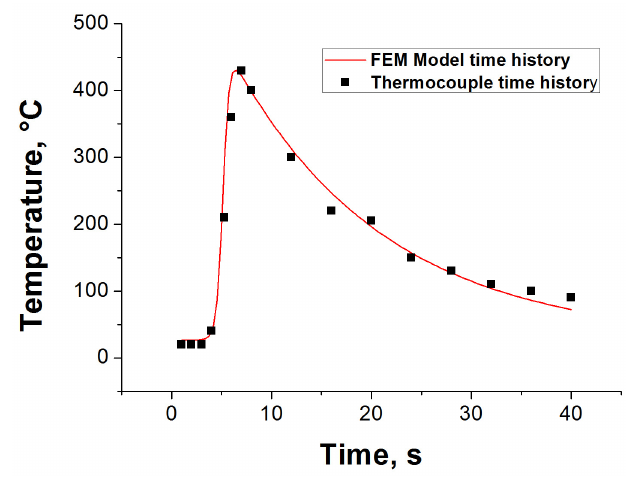
Figure 5. Model calibration curve. Laser power = 200 W and Scan speed = 16 mm/s.